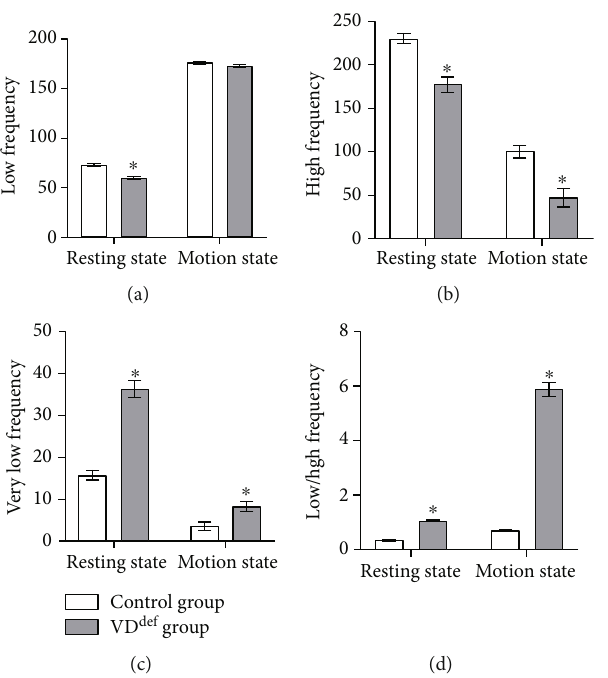
Figure 2: E ff ects of VD def on HRV in rats. LF (a), HF (b), VLF (c), and LF/HF (d) were analyzed in resting state and motor stimulation state. ∗ P < 0 : 05 vs. the control group. LF: low frequency; HF: high frequency; VLF: very low